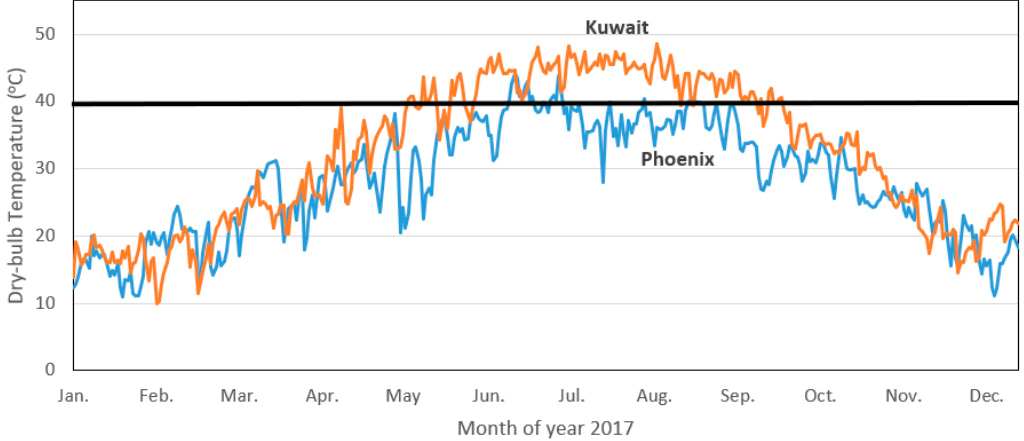
Figure 3. Annual high ambient temperature (HAT), averaged from 9 a.m. to 5 p.m., for Kuwait and Phoenix, Arizona, USA [124].